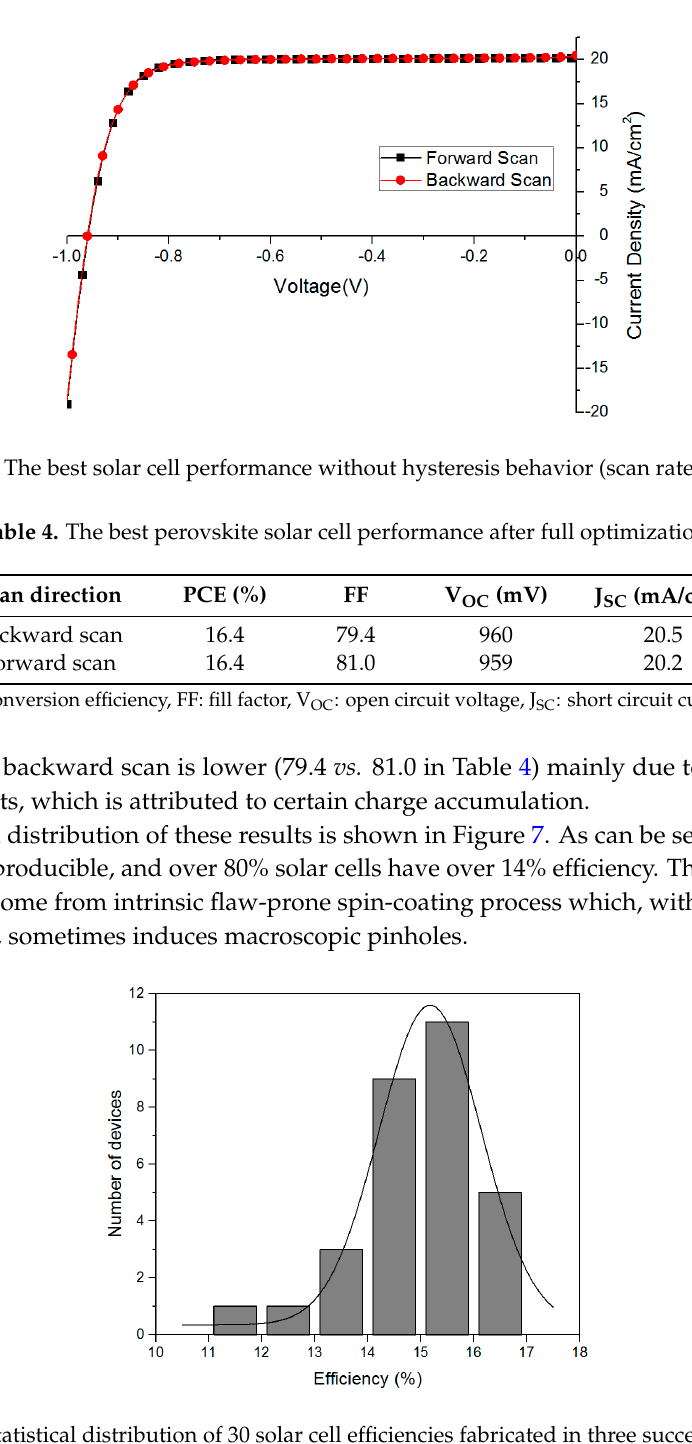
19.6 PCE: power conversion efficiency, FF: fill factor, V OC : open circuit voltage, J SC : short circuit current density